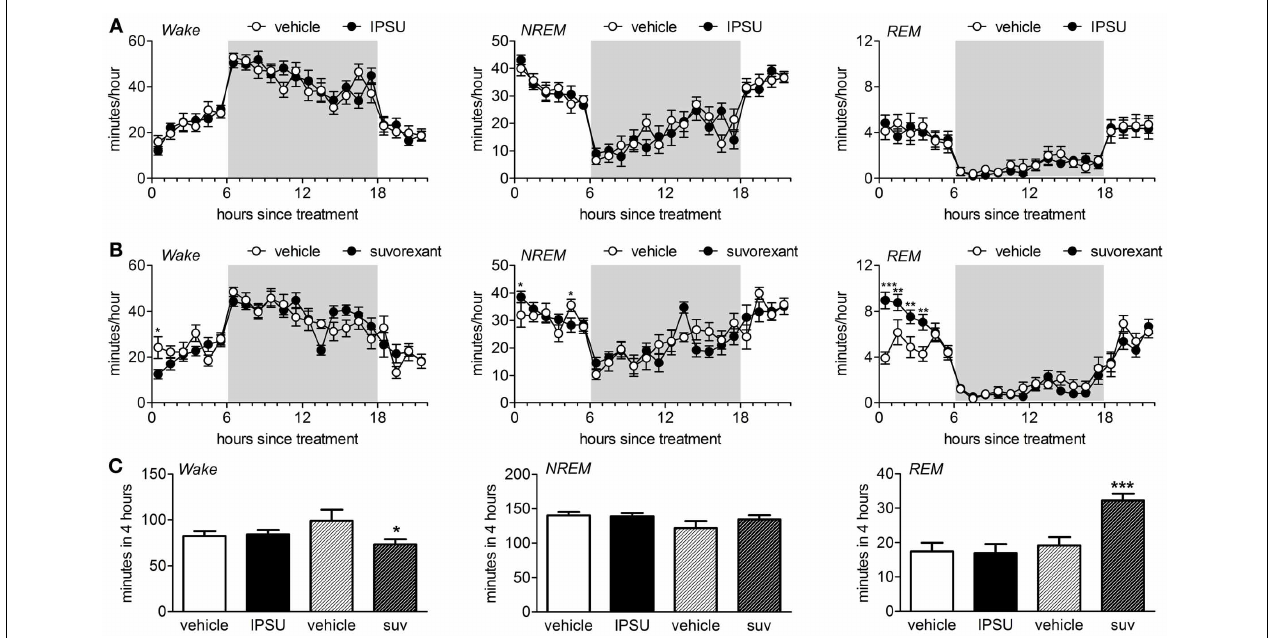
FIGURE 1 | Sleep architecture during the inactive period is perturbed by a DORA but not by an OX 2 R antagonist in C57Bl/6 mice. (A) EEG/EMG/motility signals were used to score vigilance states into wake, NREM and REM beginning from time 0, 6h into the light period. Vehicle (0.5% methylcellulose in water) or 50mg/kg IPSU were applied per os 5–15min prior to start of the recordings on successive days ( n = 11). The mean ± s.e.m. minutes per hour spent